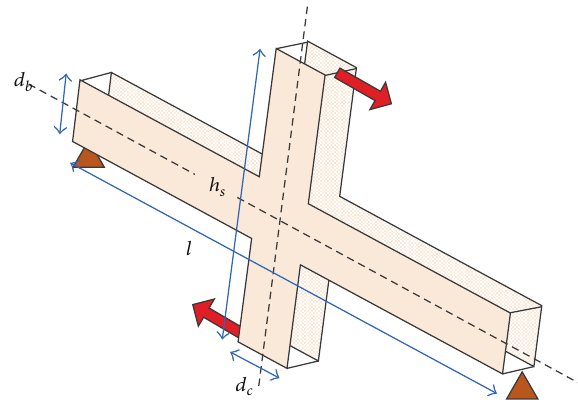
Figure 9: Subassemblage for calculation of the shear